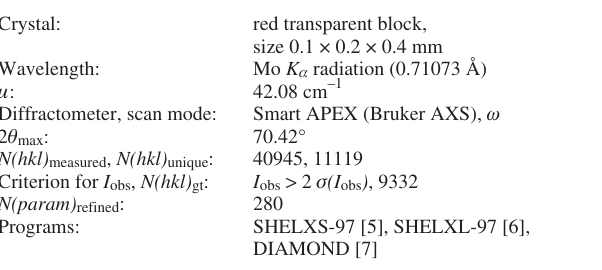
Table 1. Data collection and handling.